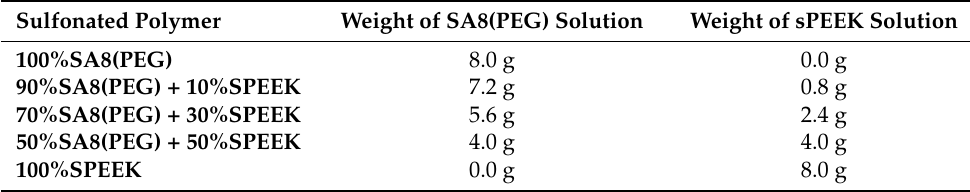
Table 4. Solid contents of SA8(PEG) and sPEEK.